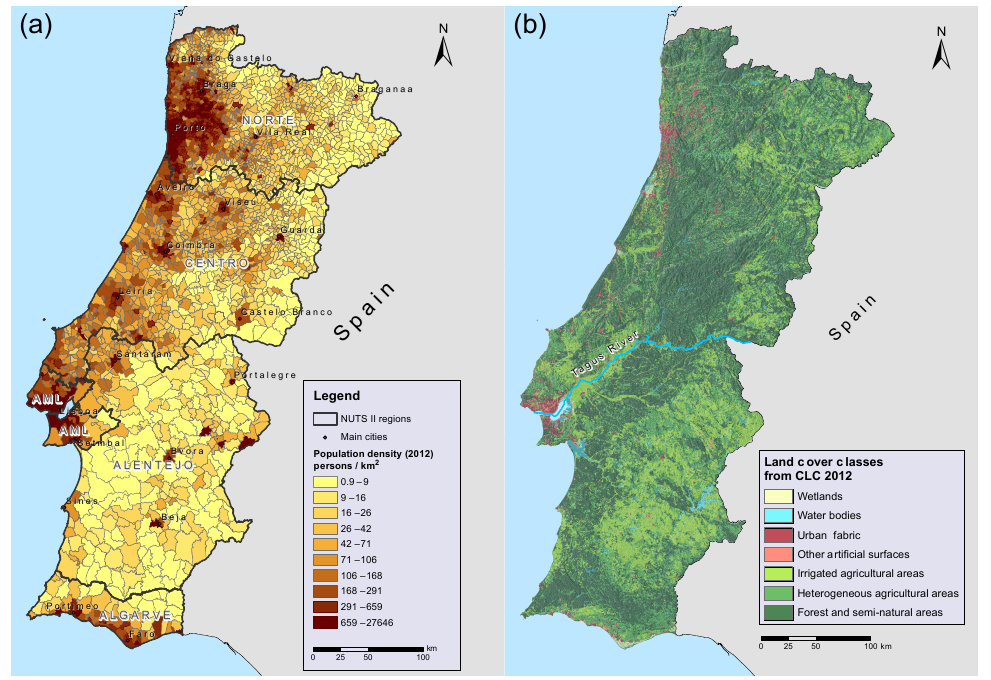
Figure 1. (a) Population density at parish level (INE, 2012) in the mainland Portugal, with the location of the of the major cities. NUTS refers to regions according to Nomenclature of Territorial Units for Statistics level II (Eurostat, 2017; Santos, 2014). (b) Land cover of mainland Portugal based on the second level of CORINE land cover inventory 2012 (EEA,